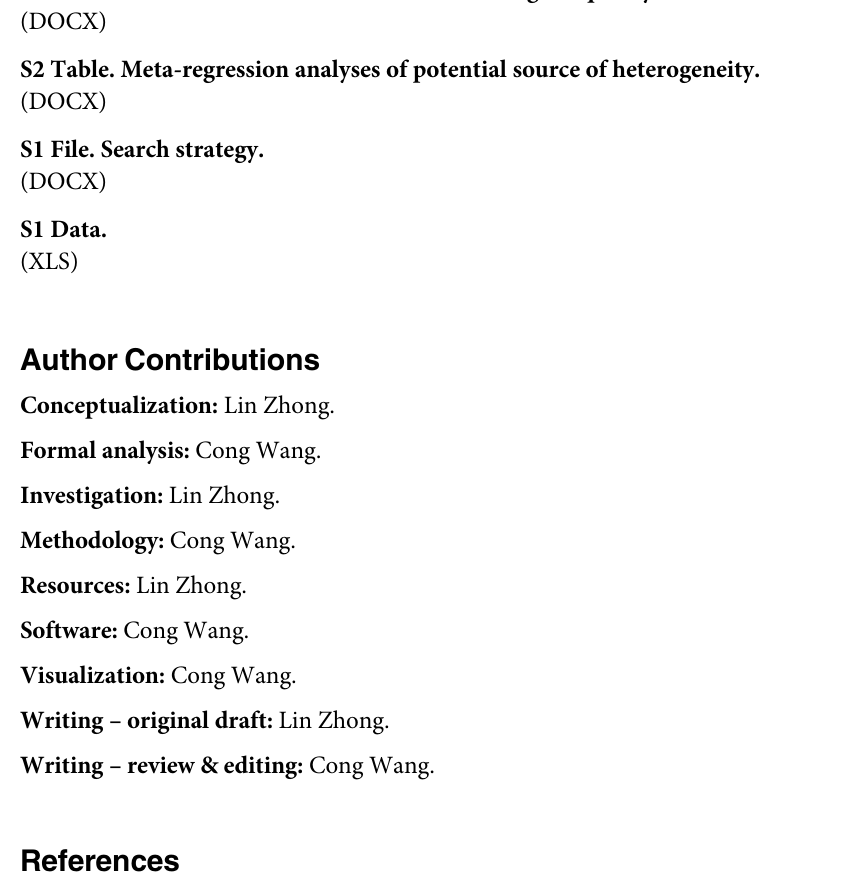
S1 Table. Baseline characteristics and methodological quality of all included studies. S2 Table. Meta-regression analyses of potential source of